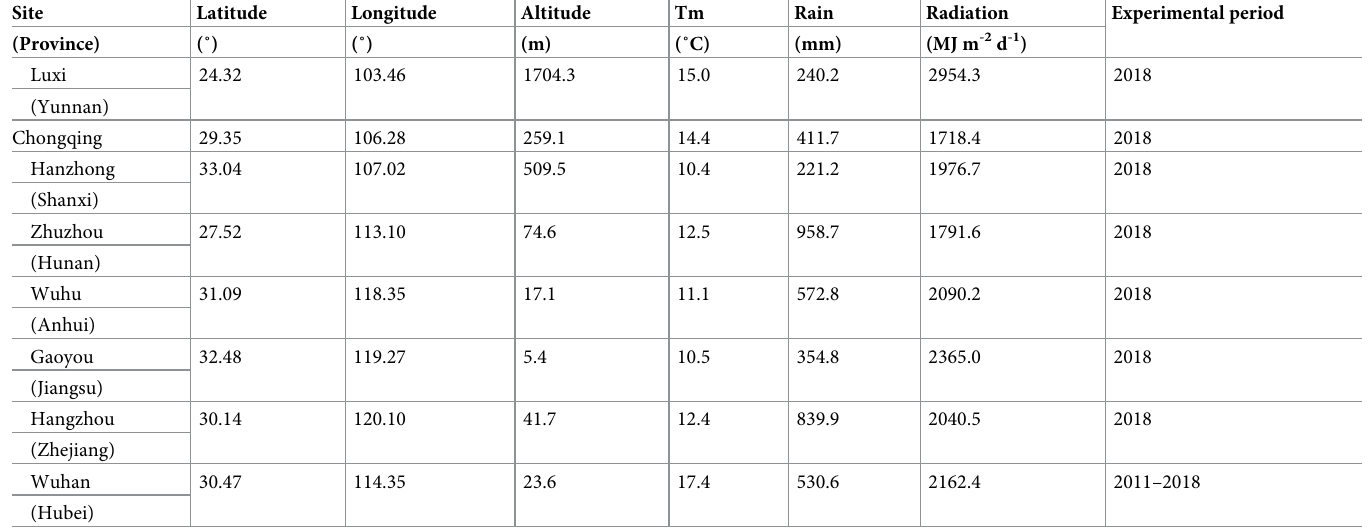
Table 1. Site information and meteorological summary of the rapeseed growing season. Site